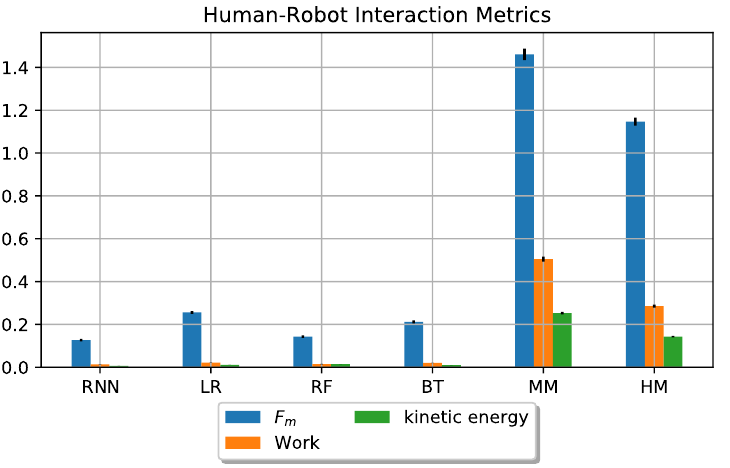
Figure 12. Interaction force (N), work (N · m), and kinetic energy (kg · m · s − 1 ) of the simulated